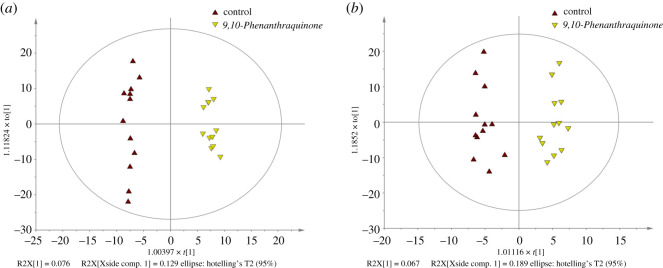
OPLS-DA score plot of metabolic profiles in T. obscurus plasma. (a) Positive ion mode; (b) negative ion mode. Brown triangles indicate the plasma samples of the control while yellow triangles indicate the plasma samples of 9,10-PQ group.